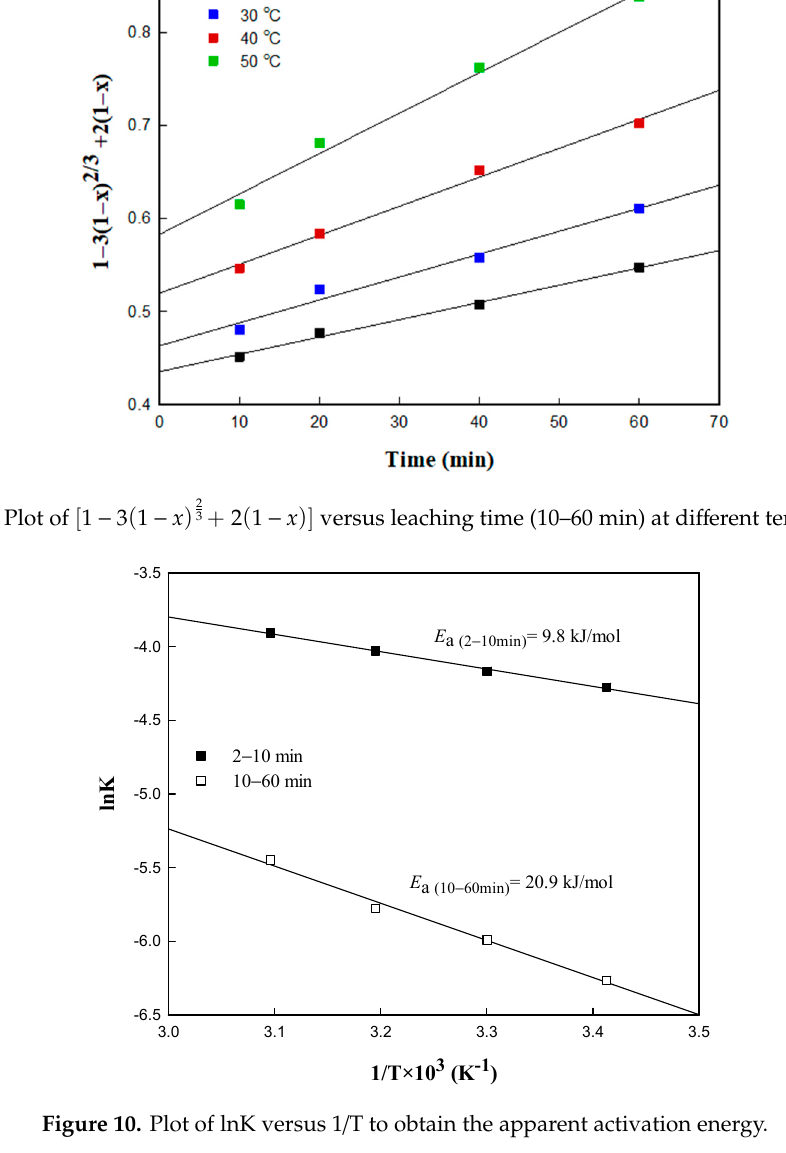
Table 3. Value of apparent rate constant for ash di ff usion control model in two leaching